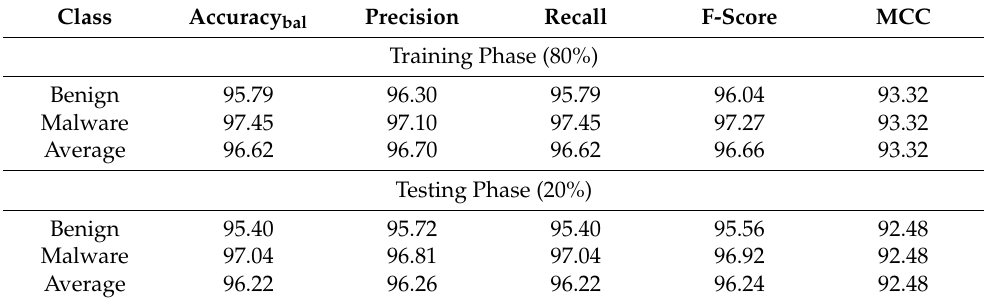
Table 2. Android malware detection outcome of the RHSODL-AMD system on 80:20 of TRS/TSS.